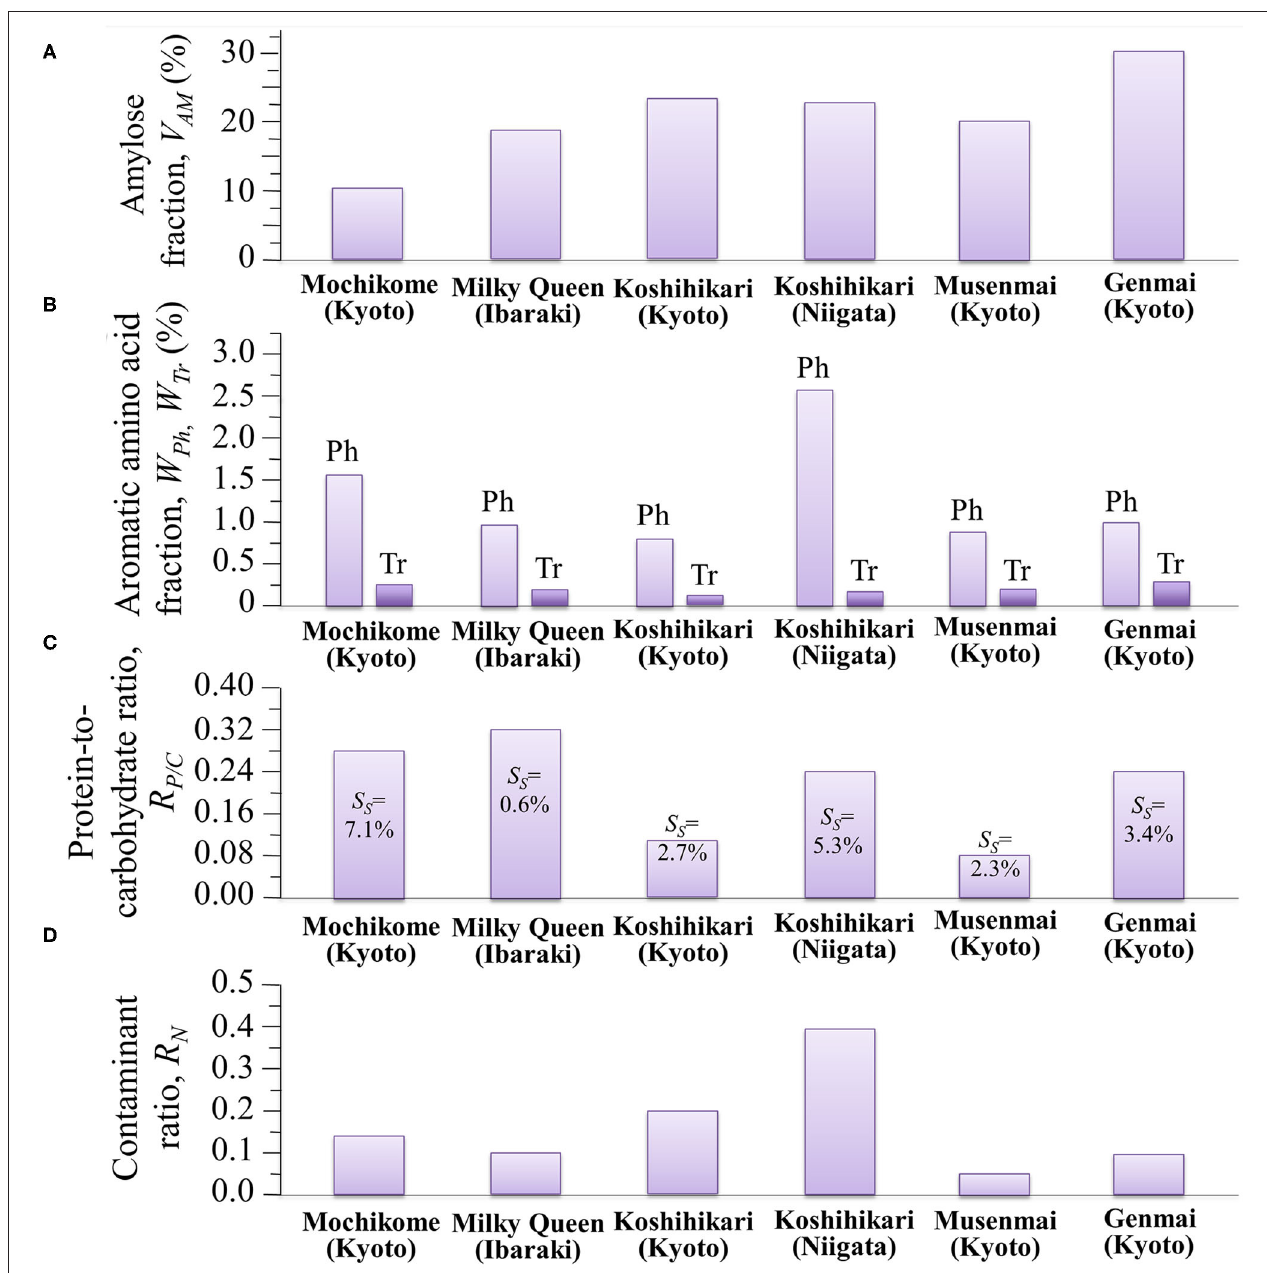
FIGURE 8 | Summary of different nutritional and contamination characteristics as measured by Raman spectroscopy in different Japanese cultivars: (A) amylose volume fraction, V AM (%); (B) aromatic amino acid volume fractions, W Ph (%) and W Tr (%) (the abbreviations Ph and Tr stem for phenylalanine and tryptophan, respectively); (C) protein-to-carbohydrate ratio, R P / C , with succinylation fractions, S S , in inset; and, (D) contaminant ratio, R N